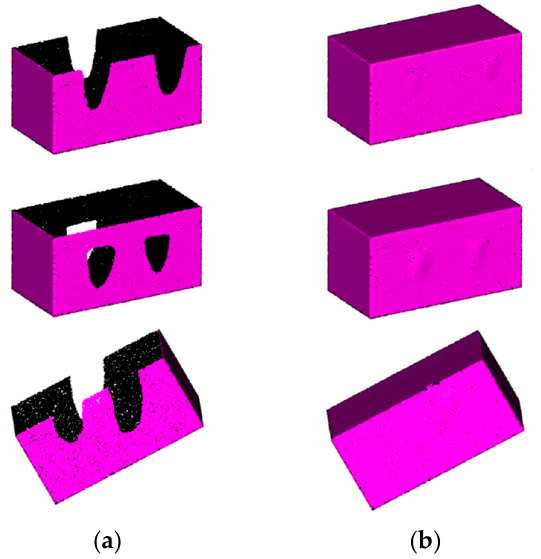
Figure 16. Repair results of cuboid point cloud models using different grasping ways: ( a ) before repair; ( b ) after repair. Table 3. The chamfer distance for cuboid point cloud models with different sizes using different grasping ways before and after repair.